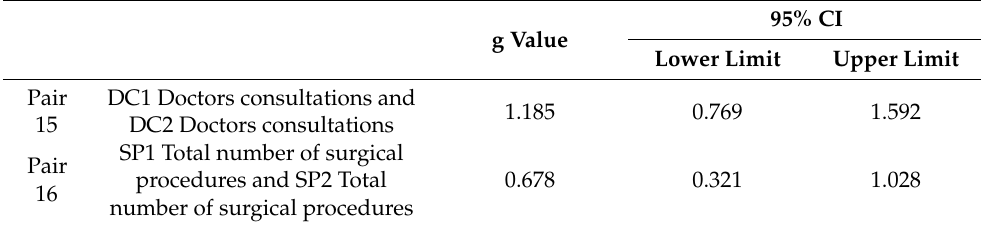
Table 12. Effect sizes for Hedge’s g dependent